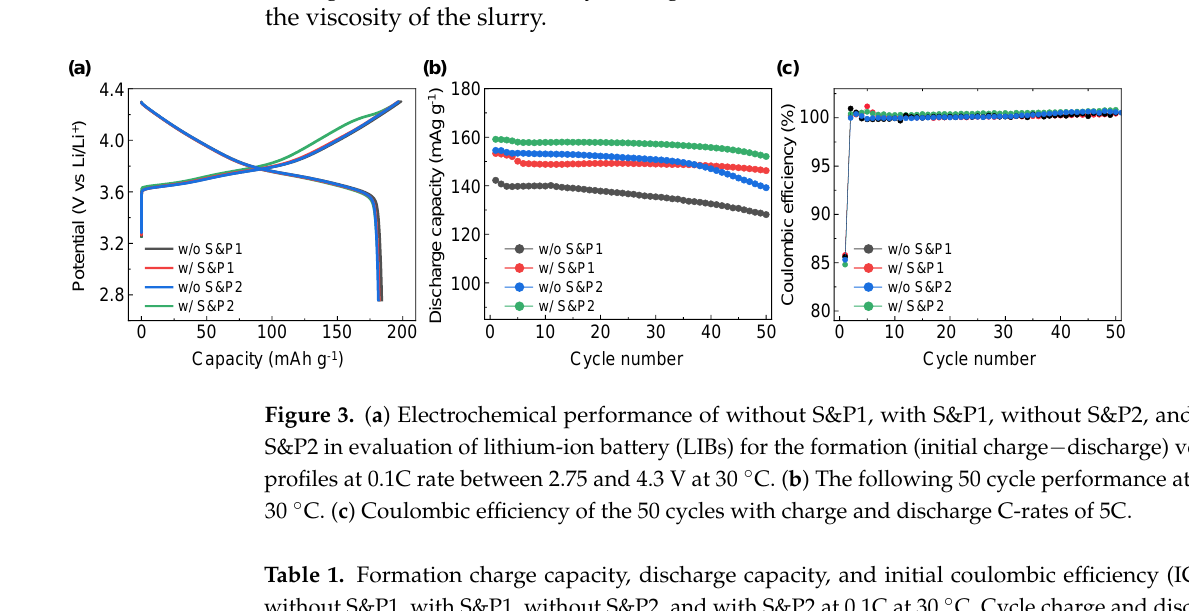
Table 1. Formation charge capacity, discharge capacity, and initial coulombic efficiency (ICE) of without S&P1, with S&P1, without S&P2, and with S&P2 at 0.1C at 30 °C. Cycle charge and dis- charge capacity of 1 cycle, 50 cycle, and capacity retention after 50 cycle at 5C.